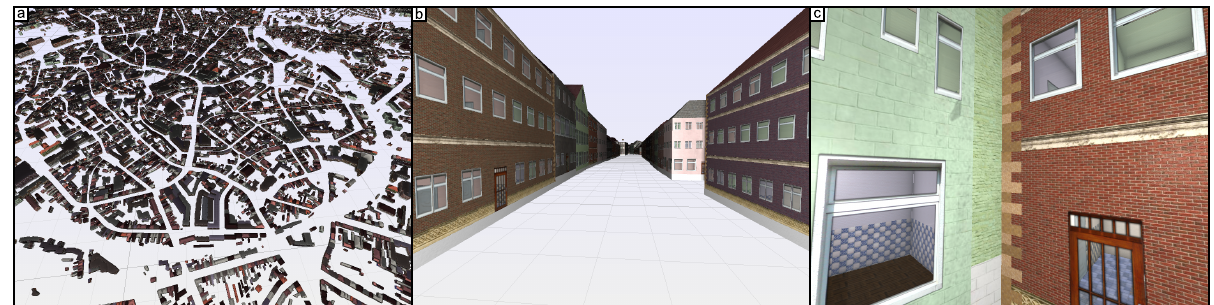
Figure 10: This image depicts the full power of our system using a texture set with only 32 elements. The evaluated grammars contain all presented operators including randomization, several layers, masking and intrusion. For our time statistics (cf. Figure 11), we have chosen different views, i.e. distance (a), street view (b) and close-up (c). executions of a fragment shader for a single pixel. Therefore, we first apply a computational cheap fragment program that renders the low resolution polygonal mesh of the city model and only stores basic information for each pixel. Afterwards, we reuse the given information in order to execute the computational expen- sive shaders per pixel including the grammar evaluation, screen space ambient occlusion and phong lighting.